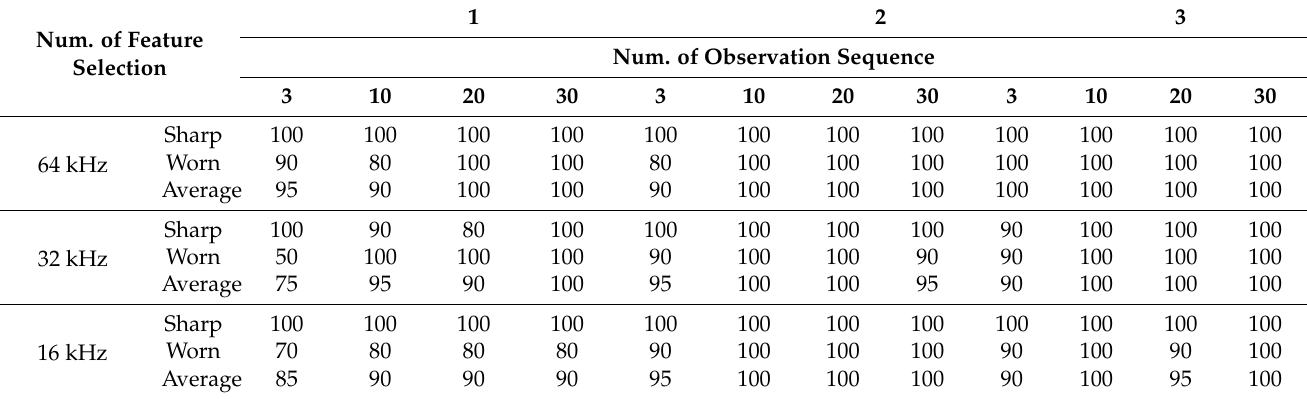
Table 8. Classification rate with different feature bandwidths and observation sequences (workpiece AE signals). Unit: